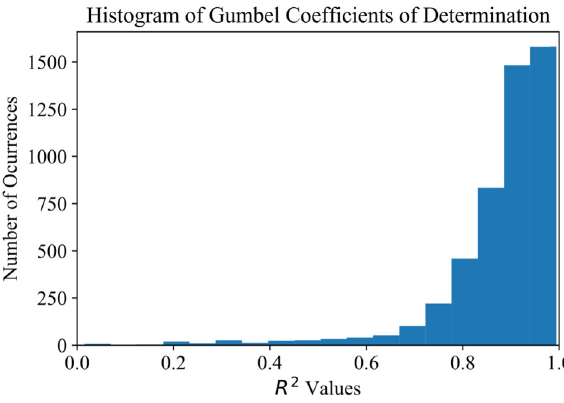
Fig. 2 Pearson Coef fi cients for the trained Gumbel distributions, n =